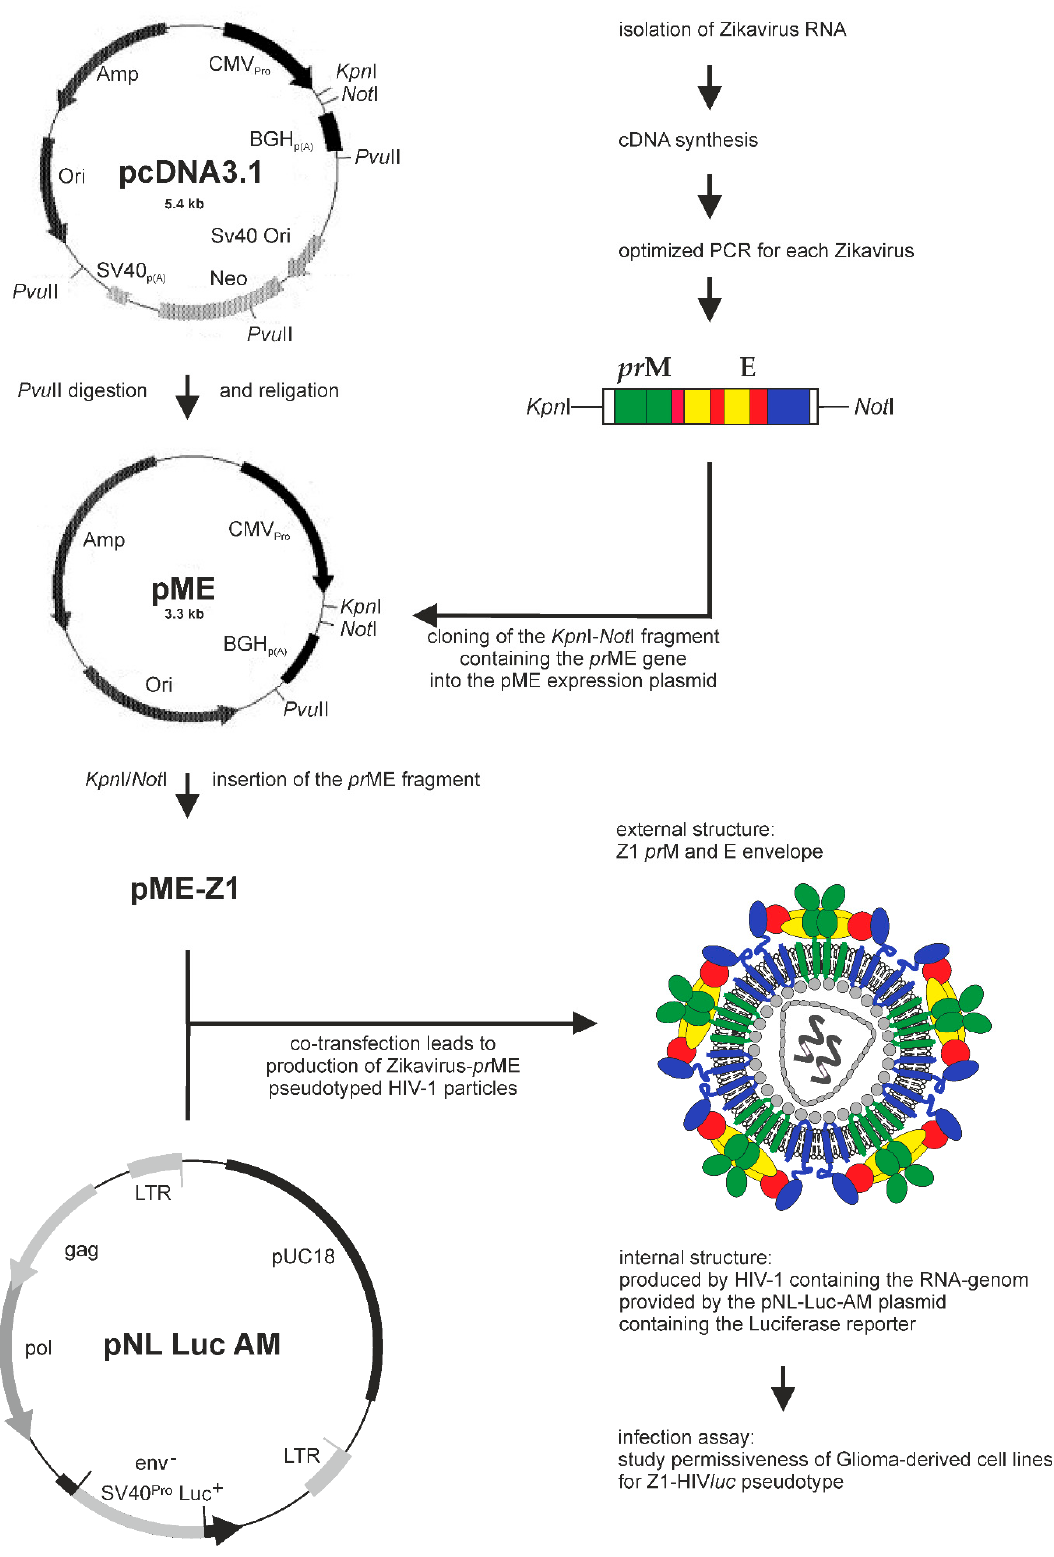
Figure A2. Schematic diagram of the cloning procedure for the production of Zika-HIV luc pseudotypes. LTR, long terminal repeat.